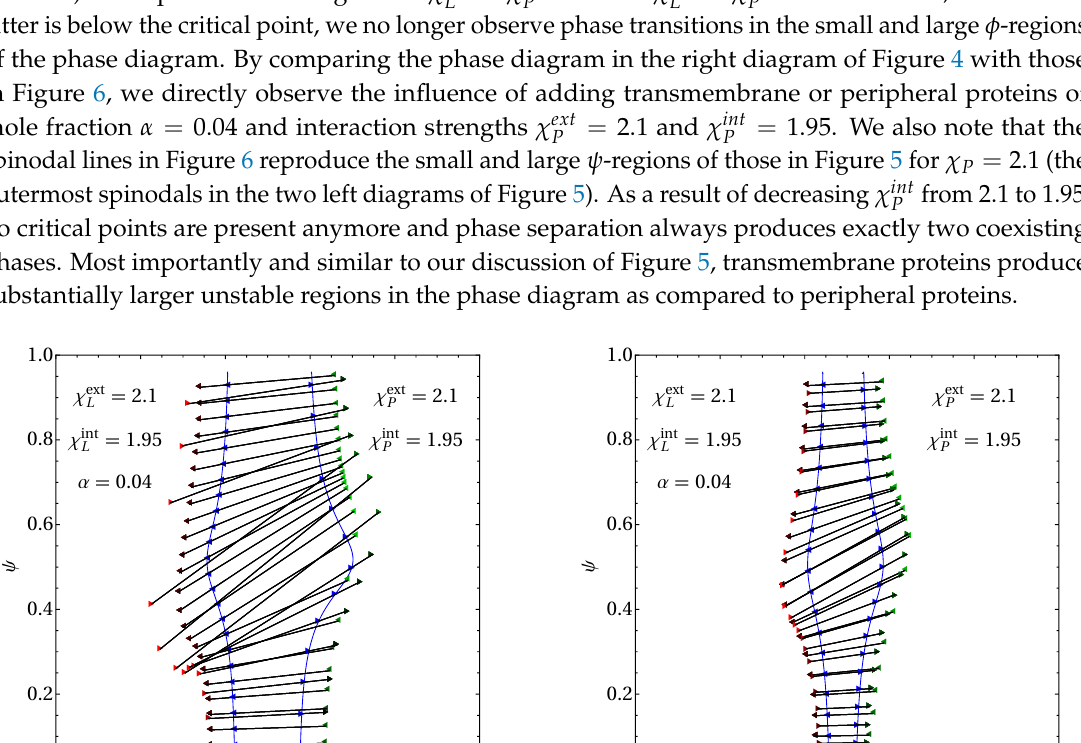
= χ ext = 2.1, χ int = χ int = 1.95, L P L P